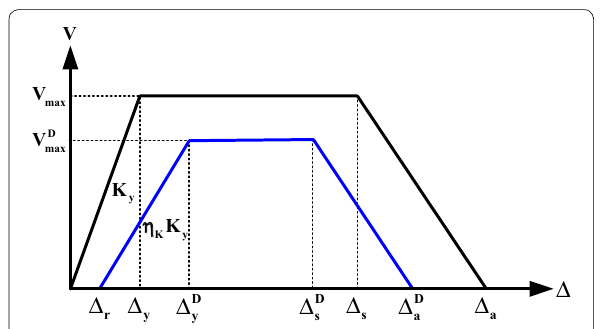
Fig. 19 Definition of the nonlinear plastic hinge for an RC column